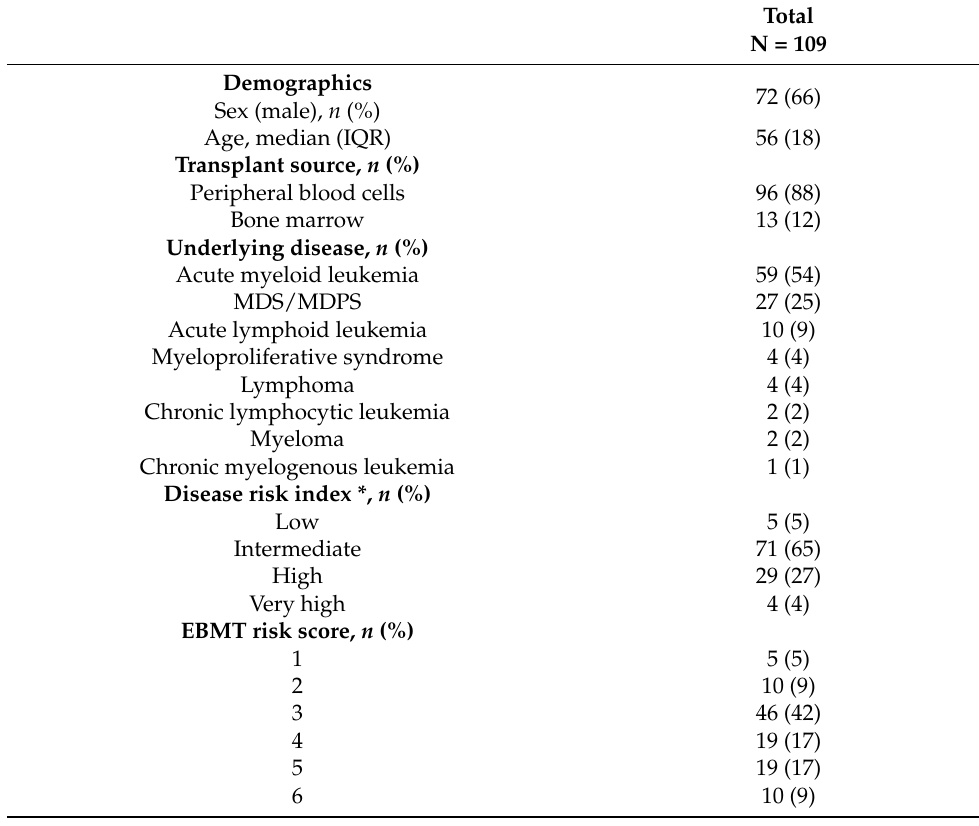
Table 1. Patients’ characteristics (109 allo-HSCT